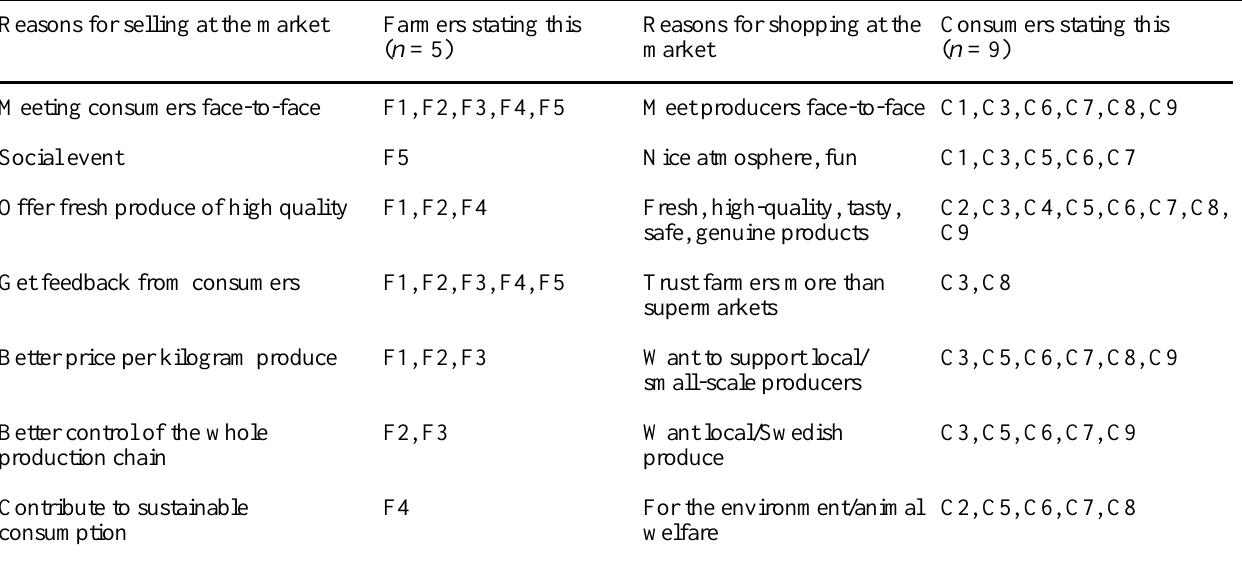
Table 7 . Reasons why farmers and customers attended the farmers' market. Reasons for selling at the